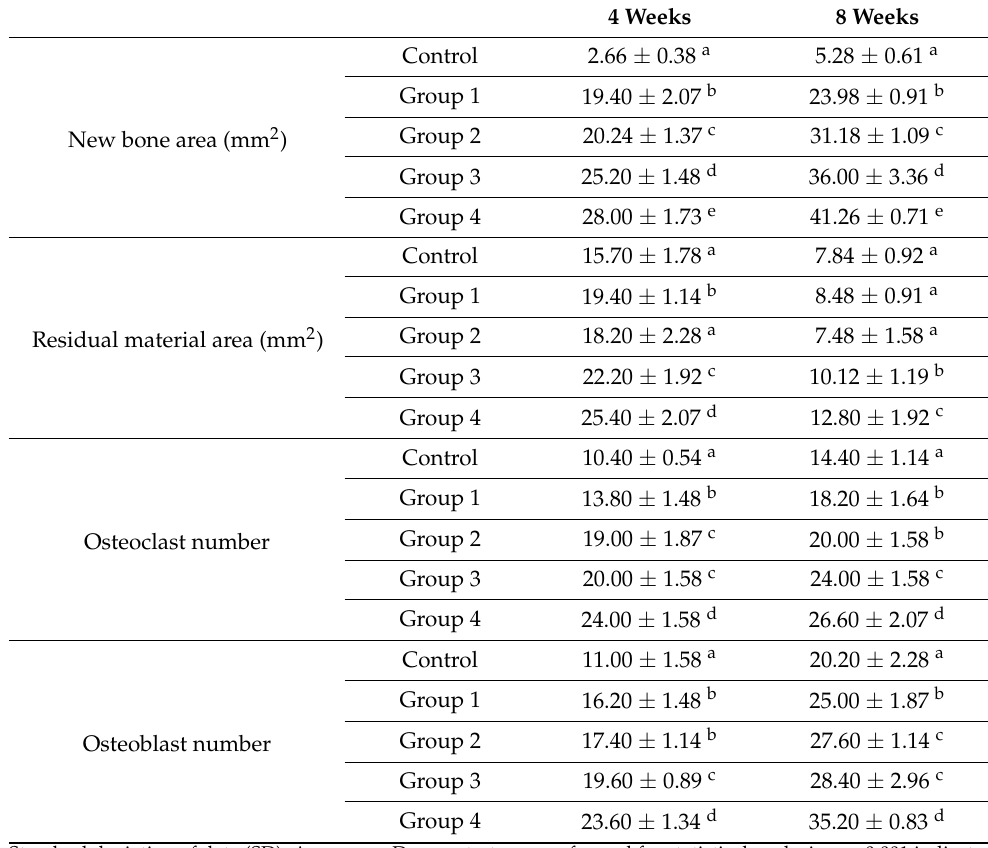
Standard deviation of data (SD). A one-way Duncan test was performed for statistical analysis. p < 0.001 indicates that differences in the means of groups with different superscript letters in the same column are statistically significant. Differences between groups with the same superscript are statistically